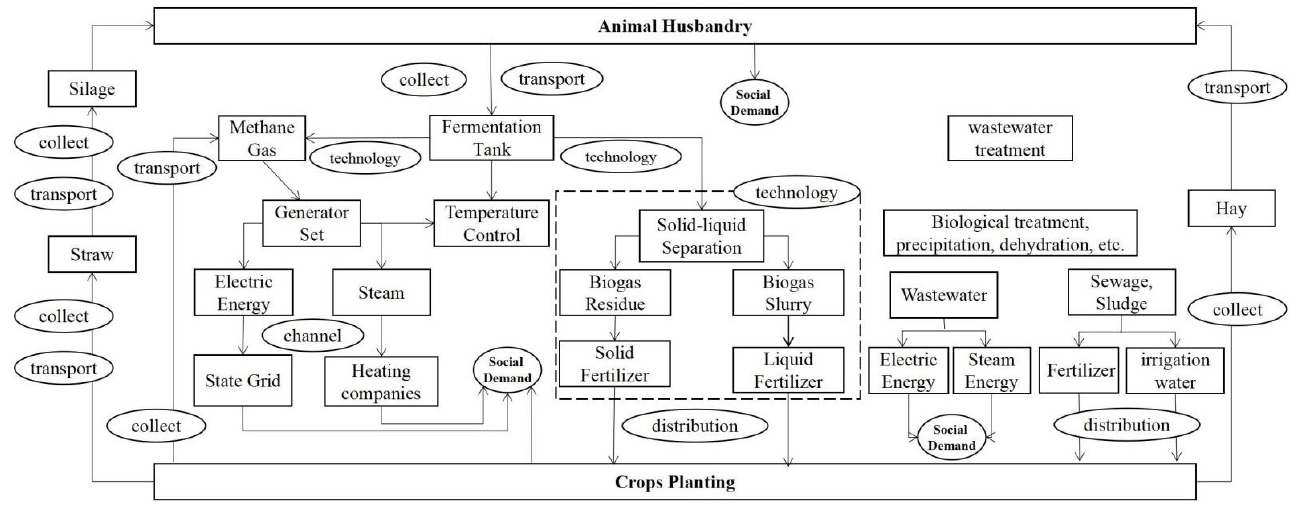
Figure 4. Circular agriculture development route diagram.